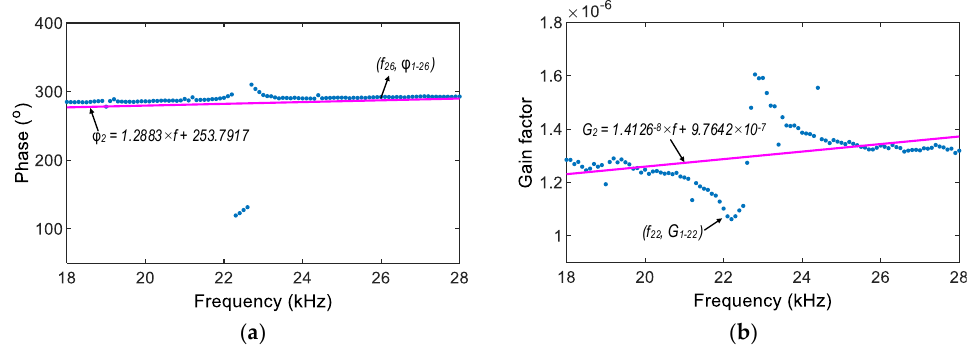
, ( b ) Gain Figure 16. Regression models for impedance phase angle and gain factor. ( a ) Phase fit ϕ 2 , ( b ) Gain 2